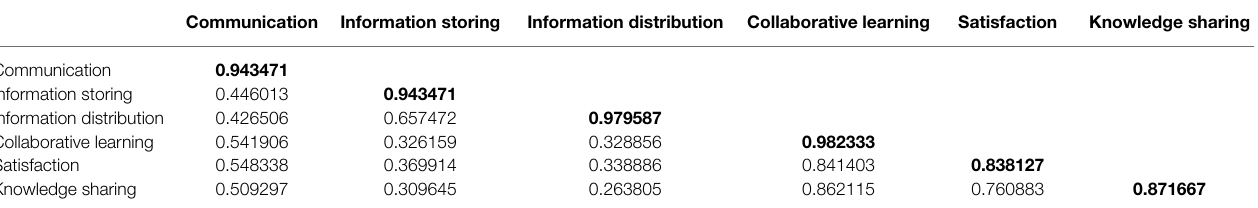
TABLE 2 | Discriminant